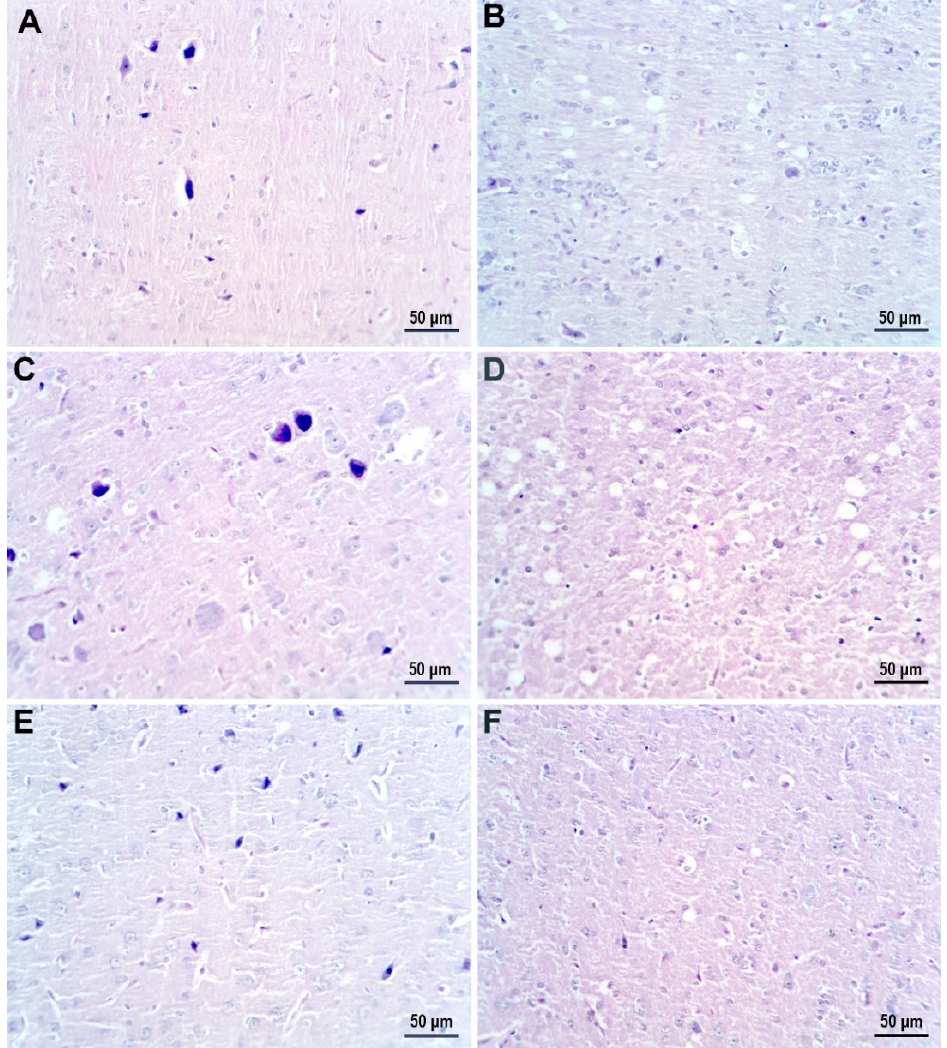
Figure 12. Hematoxylin-eosin-stained sections of cerebral-cortex tissue. ( A , B ) Control group displaying normal morphology. ( C ) Groups treated with low dose of AgNP and sacrificed immediately after treatment. ( E ) Groups treated with high dose of AgNP and sacrificed immediately after treatment. ( D ) Groups treated with low dose of AgNP and sacrificed 15 days post-treatment. ( F ) Groups treated with high dose of AgNP and sacrificed 15 days